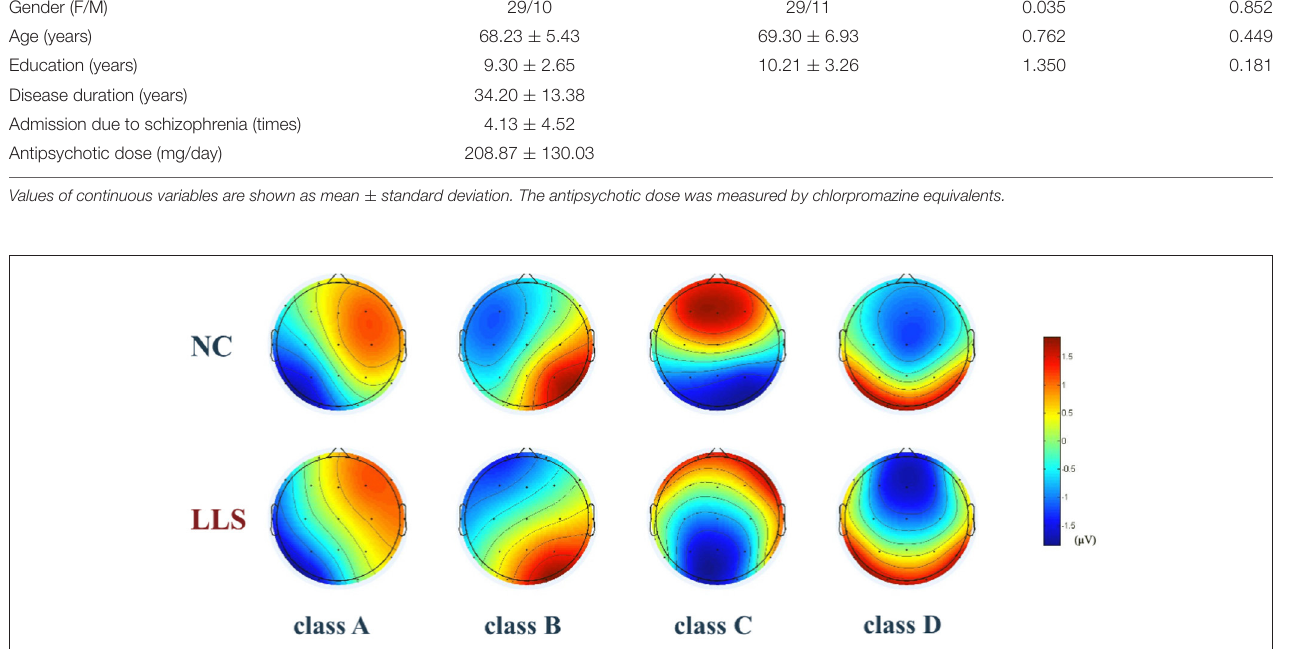
some studies included first-episode unmedicated patients (48, 49), while others included chronic medicated patients (28,